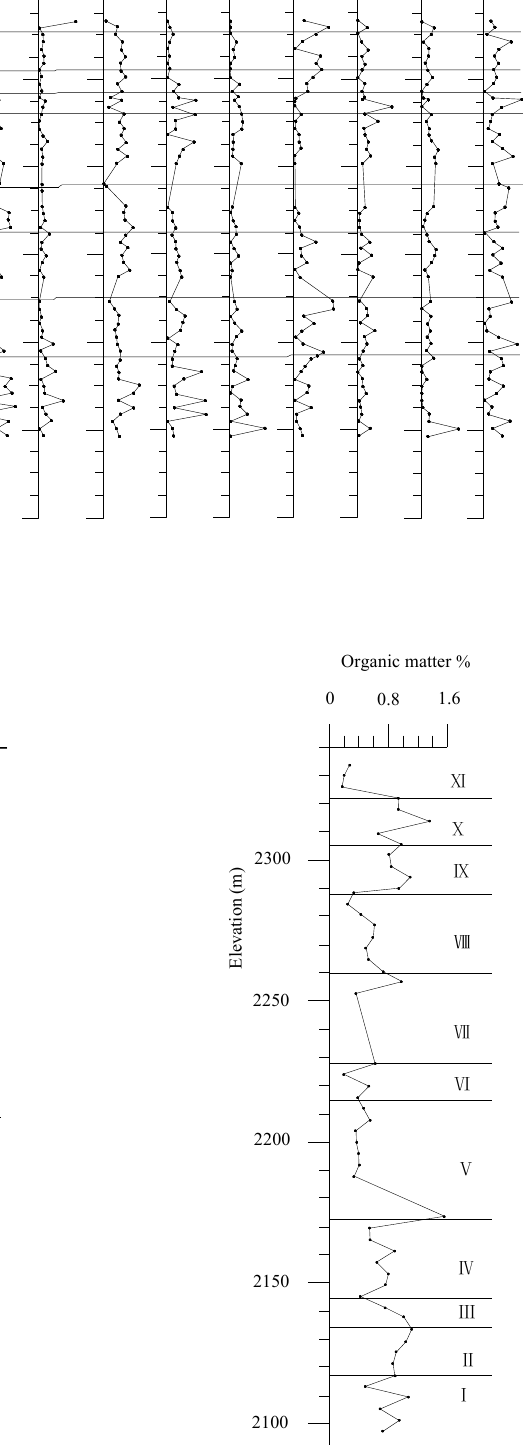
Figure 6. Carbon and oxygen isotopes: (a) ratio of δ 13 C to δ 18 O; Fig. 6. Carbon and oxygen isotopes: a). ratio of δ 13 C to δ 18 O; and b). values of δ 13 C and δ 18 O and (b) values of δ 13 C and δ 18 O. Fig. 7. Average content of organic matter